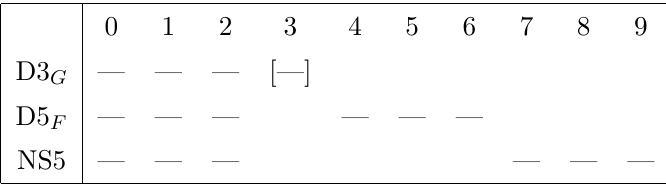
Table 2. T-dual IIB realization. The result is a Hanany-Witten scenario after we decompactify the x 4 direction.